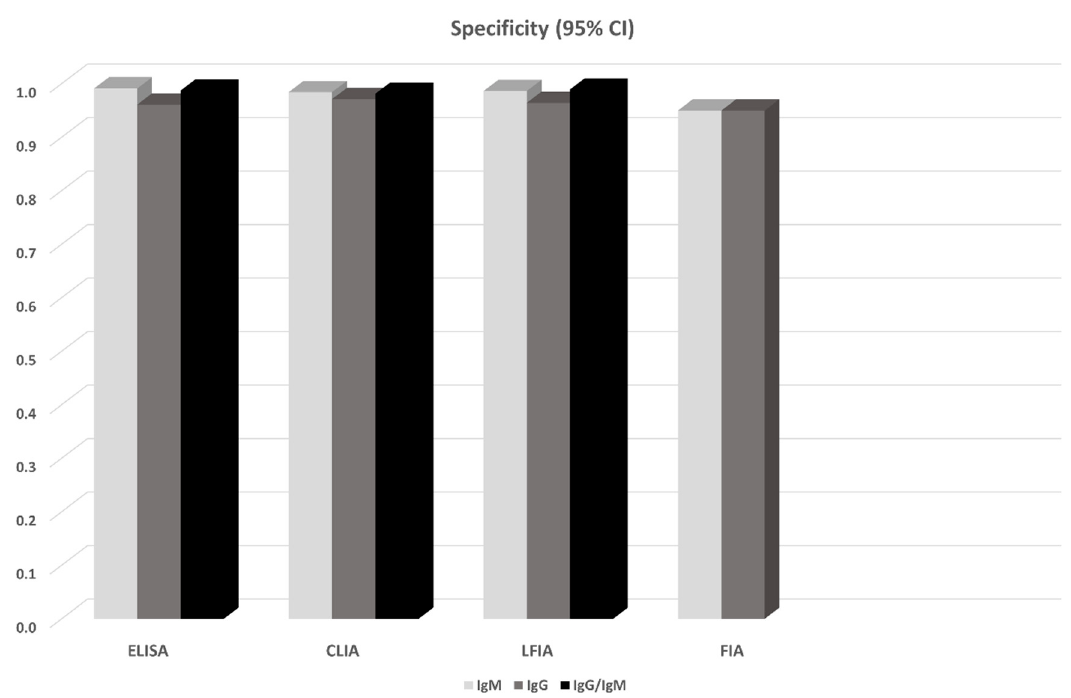
Figure 3. Pooled specificity of antibody tests obtained from meta-analysis. For the details see Table 2 and the Results section.